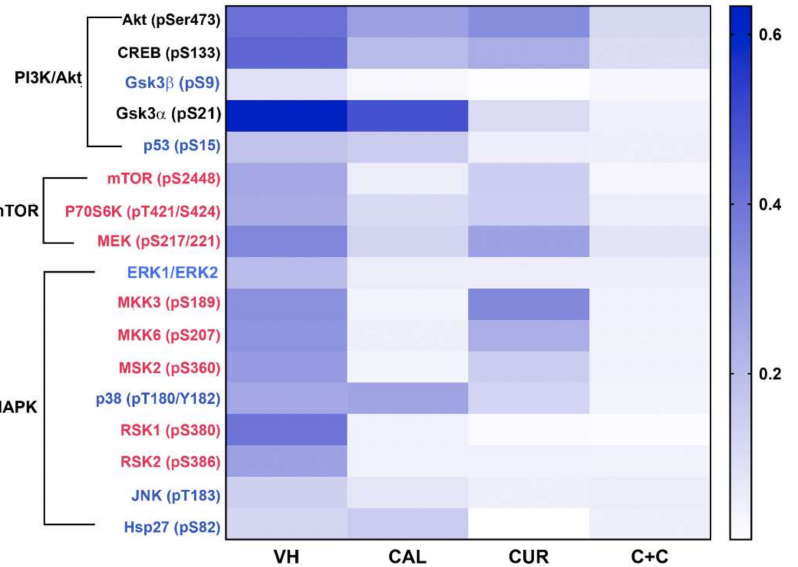
Figure 3. In MBCDF-T/EA.hy926 co-cultures, calcitriol and curcumin inhibited the phosphorylation of several protein targets of the MAPK, PI3K/Akt/mTOR, PI3K/Akt/CREB and PI3K/Akt/Gsk signaling pathways. The phosphorylation profile of kinases involved in signaling pathways relevant to VM was differentially inhibited by calcitriol (CAL, 10 nM), curcumin (CUR, 20 µ M) and their com- bination (C+C). A semi-supervised hierarchical clustering of the targets differentially phosphorylated detected with a multiplex antibody array was carried out and results are shown in the heat map clustered in three main signaling pathways: PI3K/Akt, mTOR and MAPK. The more strongly phos- phorylated kinases in vehicle-treated co-cultures (VH) are labeled in black. Kinases mostly inhibited by calcitriol are labeled in red, while phosphorylated protein targets more strongly downregulated by curcumin are labeled in blue. N =